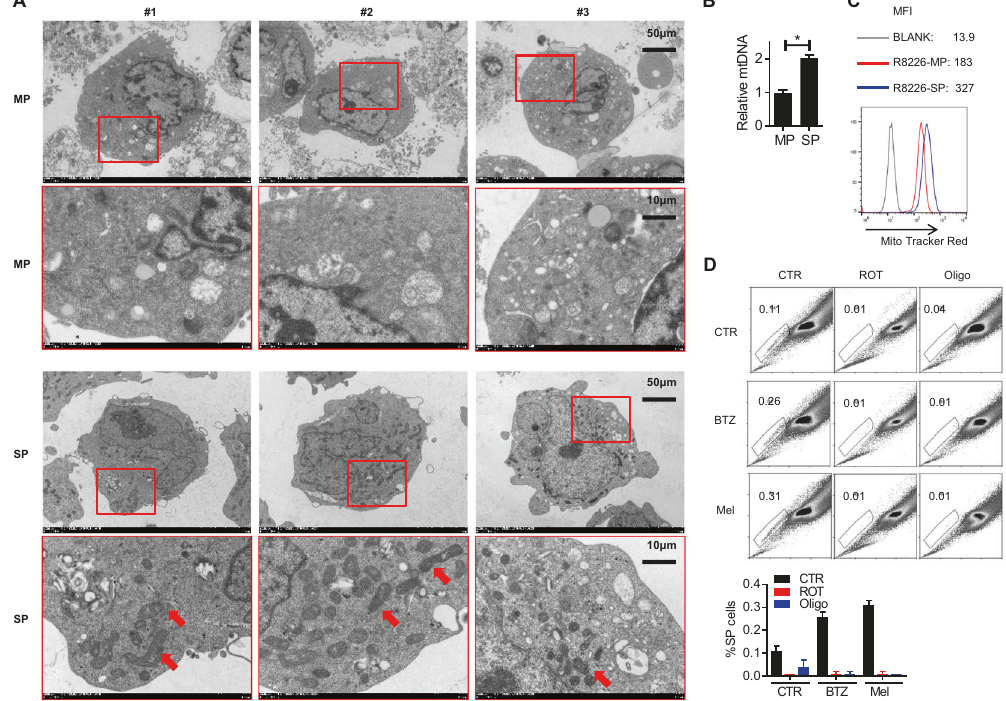
Fig. 5 Myeloma side population cells have increased the number of mitochondria. A Transmission electron microscopy images of RPMI8226 SP and MP cells. B Mitochondria DNA (mtDNA) of RPMI8226 SP and MP cells were examined by qPCR. C Mito-tracker staining of RPMI8226 SP and MP cells. MFI mean fl uorescence index. D RPMI8226 MM cells were treated with oligomycin (Oligo, 3 μ M) or rotenone (ROT, 1 μ M) for 4 h. The SP cell ratio was examined by Hoechst staining. Data are the mean of three independent experiments in three replicates. * p <